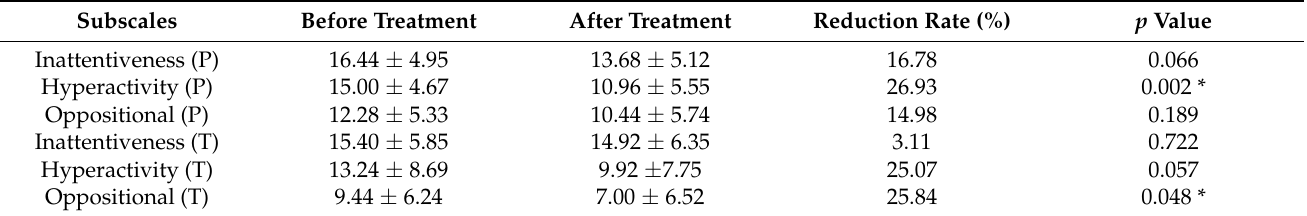
Table 1. Comparison of SNAP subscale scores in 25 patients with ADHD before and after